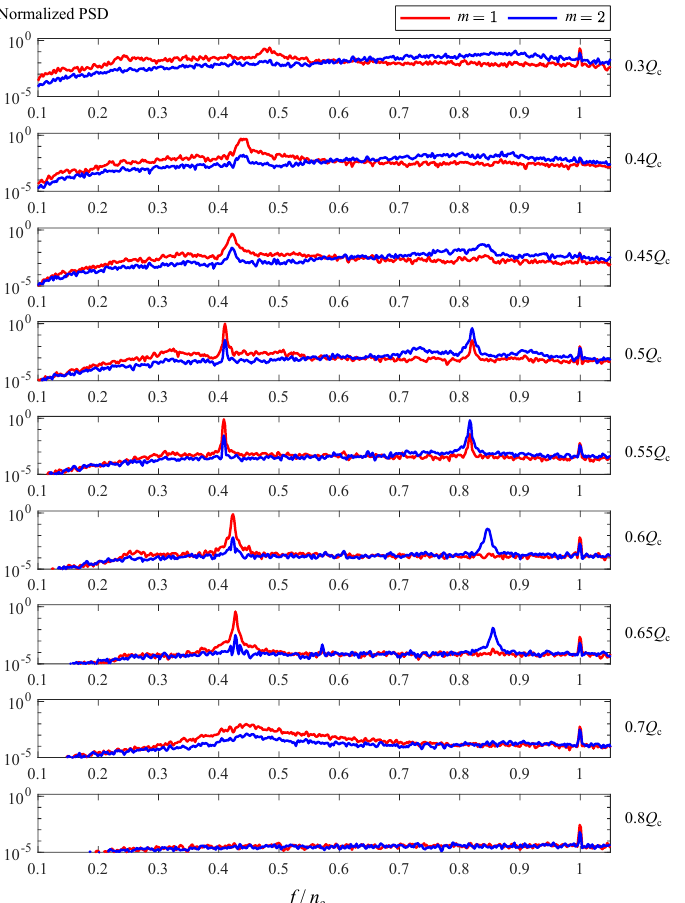
Figure 3. Pressure fluctuation spectra in terms of normalized PSD for the azimuthal modes m = 1 and m = 2 and different flow rates Q / Q c